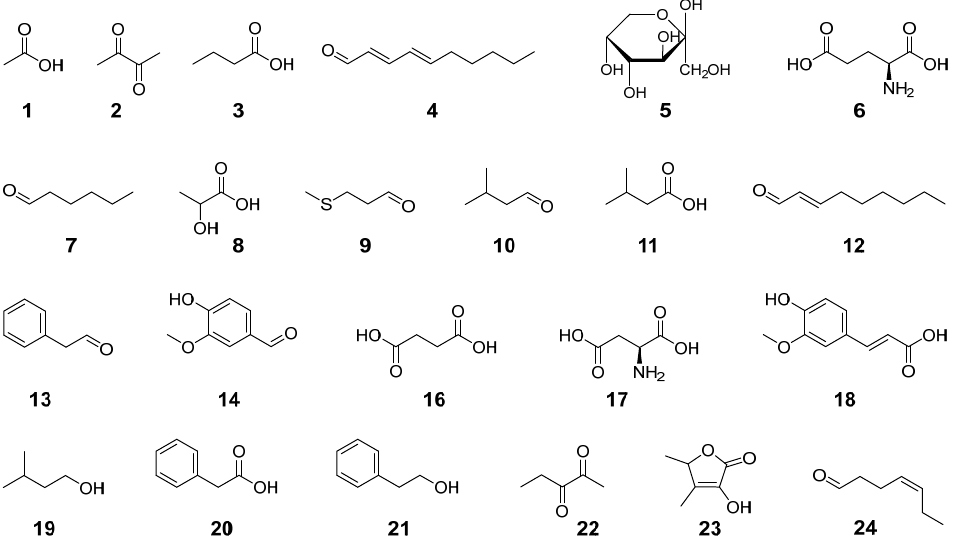
Figure 2. Chemical structures of the tastants and odorants present in the total taste and aroma recombinant of sourdough rye bread crumb: acetic acid ( 1 ), 2,3-butanedione ( 2 ), butyric acid ( 3 ), ( E , E )-2,4-decadienal ( 4 ), D -fructose ( 5 ), L-glutamic acid ( 6 ), hexanal ( 7 ), lactic acid ( 8 ), methional ( 9 ), 3-methylbutanal ( 10 ), 3-methylbutyric acid ( 11 ), ( E )-2-nonenal ( 12 ), phenylacetaldehyde ( 13 ), vanillin ( 14 ), succinic acid ( 16 ), L -aspartic acid ( 17 ), ferulic acid ( 18 ), 3-methylbutanol ( 19 ), phenylacetic acid ( 20 ), 2-phenylethanol ( 21 ), 2,3-pentanedione ( 22 ), sotolon ( 23 ), and ( Z )-4-heptenal ( 24 ). Table 4. Odor qualities, odor thresholds, concentrations, and odor activity values in water ( OAV water ) and starch ( OAV starch ) of key aroma compounds in the crumb of rye